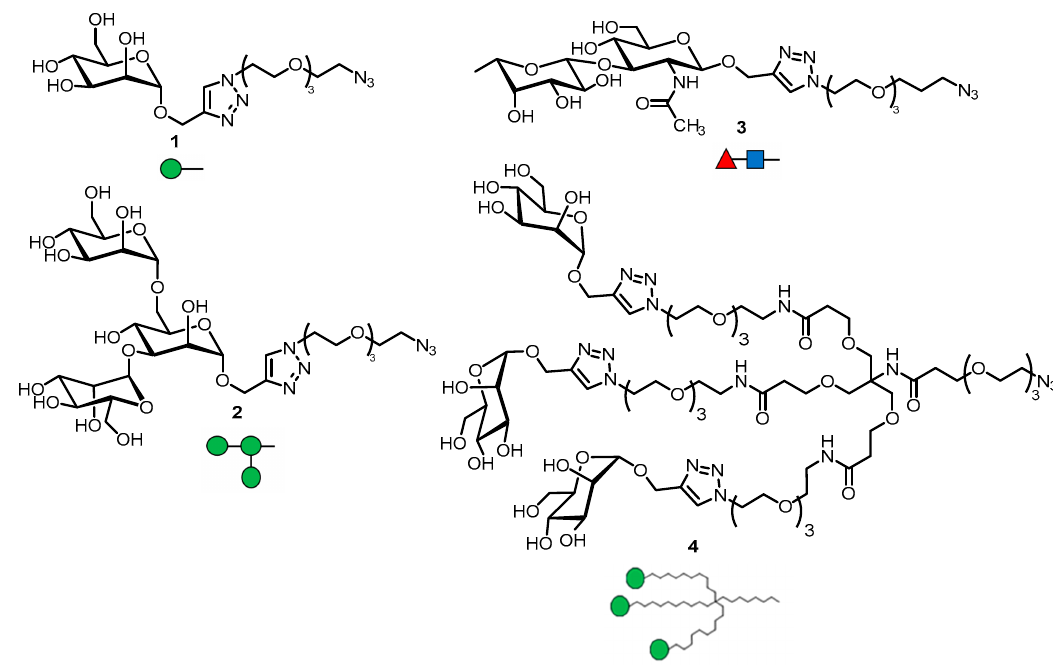
Figure 1. Chemical structures of selected carbohydrate ligands for receptor dendritic cell-specific intercellular adhesion molecule-3-grabbing non-integrin (DC-SIGN) targeting and corresponding symbol nomenclature adopted by the consortium for functional glycomics.[28]